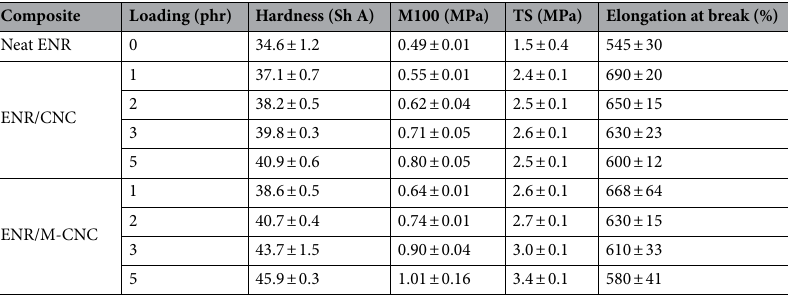
Table 1. Mechanical properties of the ENR